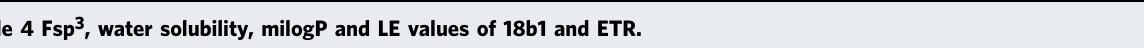
Table 4 Fsp 3 , water solubility, milogP and LE values of 18b1 and ETR.